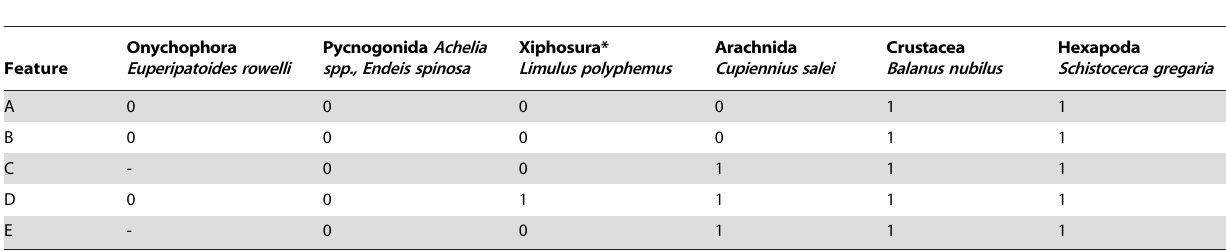
Table 1. Data matrix with pycnogonid eye features (this study) compared to median eyes of other arthropods (citations for exemplary taxa used are given above).